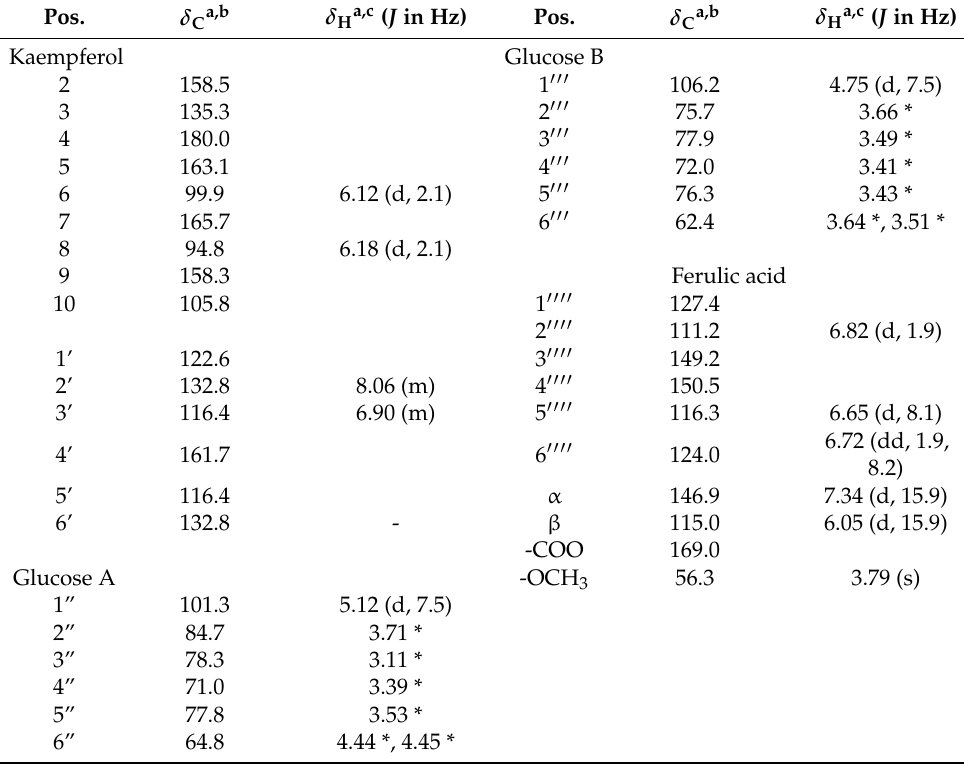
Table 1. NMR spectroscopic data for compound 1.